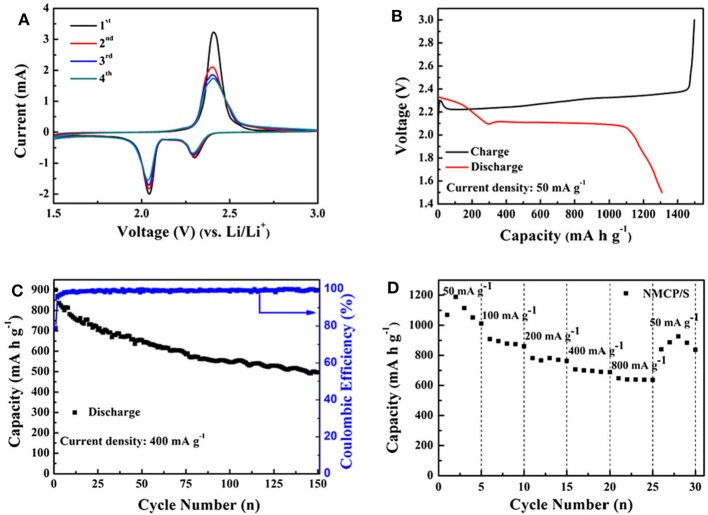
NMCP/S electrochemical performance. (A) CV curves, (B) charge/discharge profiles at 50 rnA g−1
(C) cycling performance at 400 rnA g−1, and (D) rate performance at 50 rnA g−1 From Zhang et al. (2019) with permission from SpringerLink.